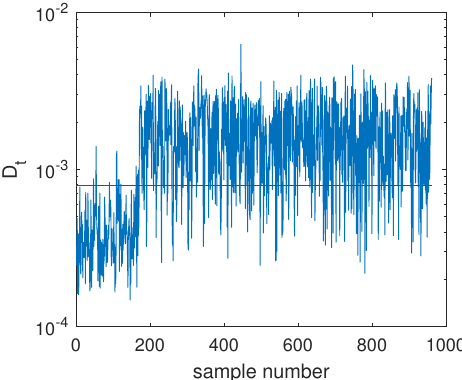
Figure 9. Fault detection chart of fault F19 based on